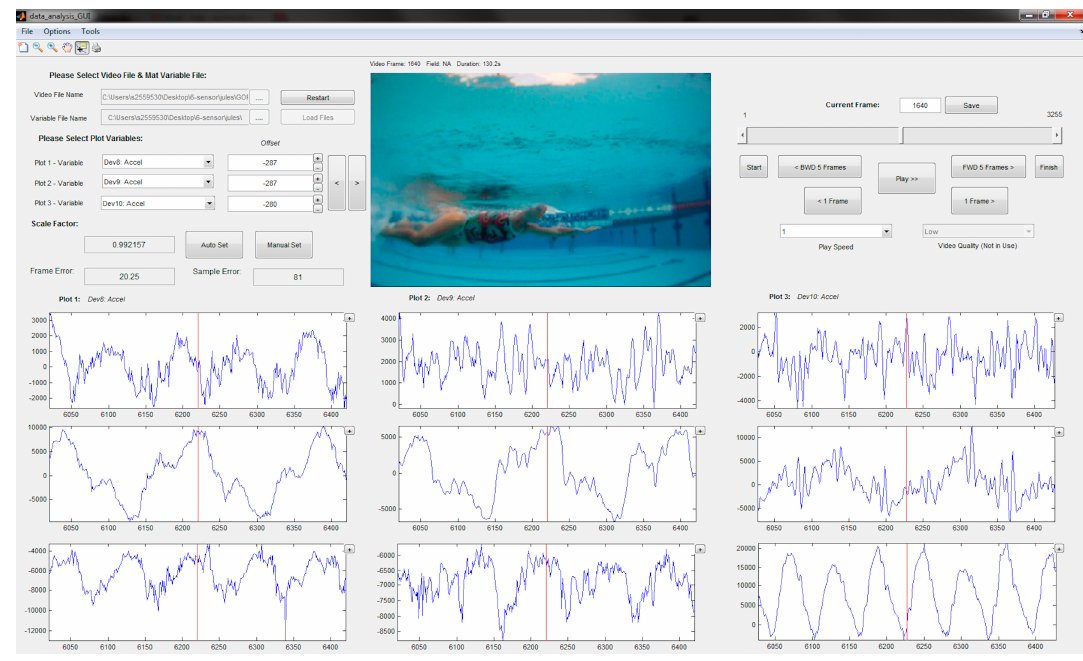
Figure 6. SABEL data analysis with synchronised inertial sensor data and video.